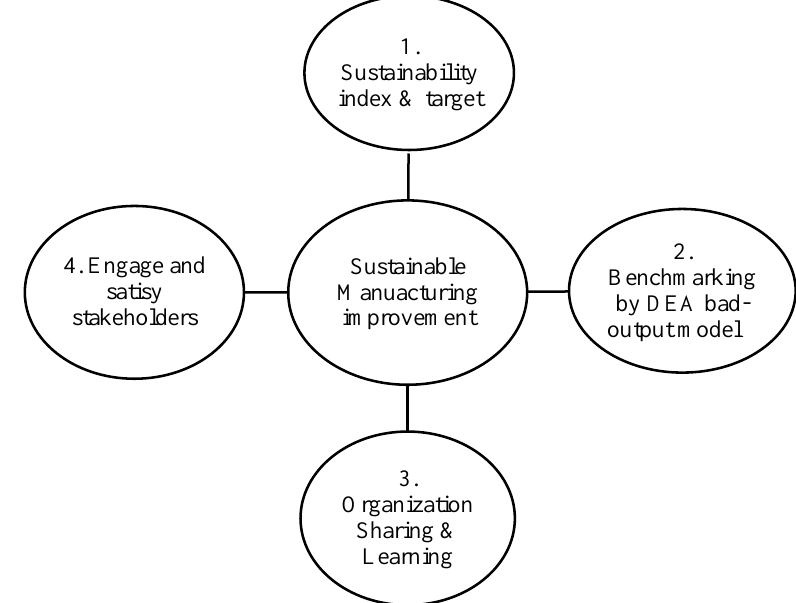
Figure 10. Contributions for the sustainable manufacturing.